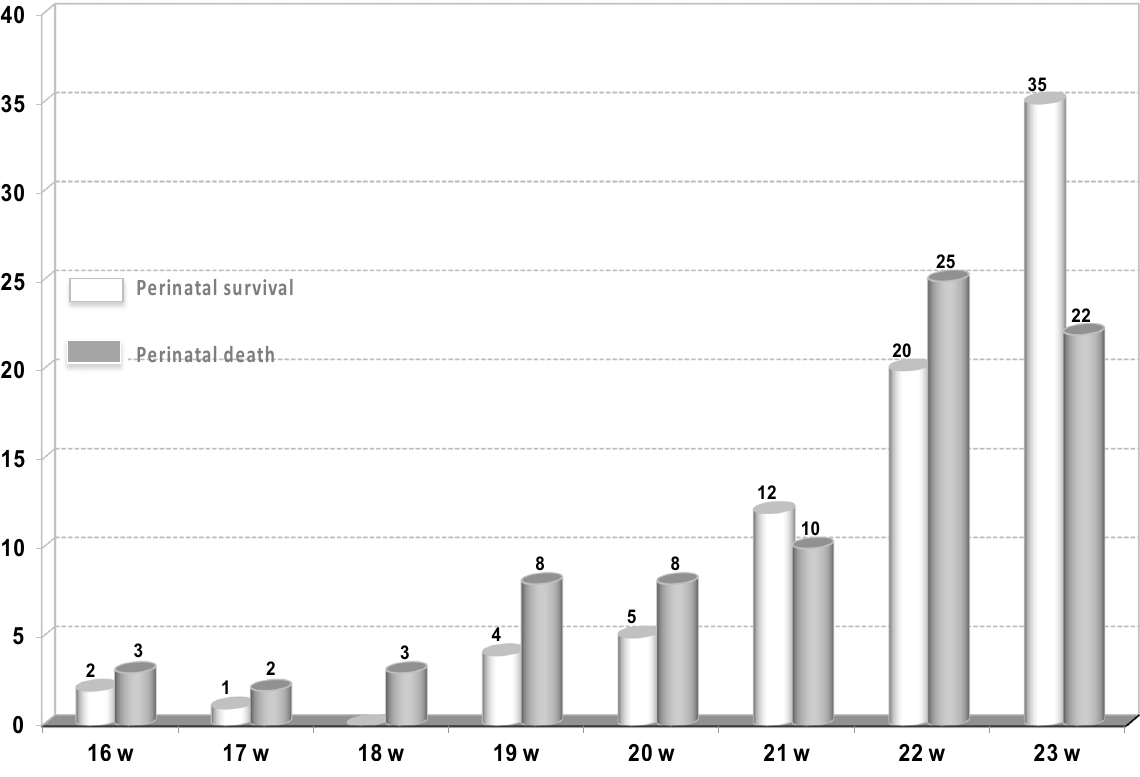
Figure 9. Perinatal mortality and survival in cases of pre-viable PPROM .